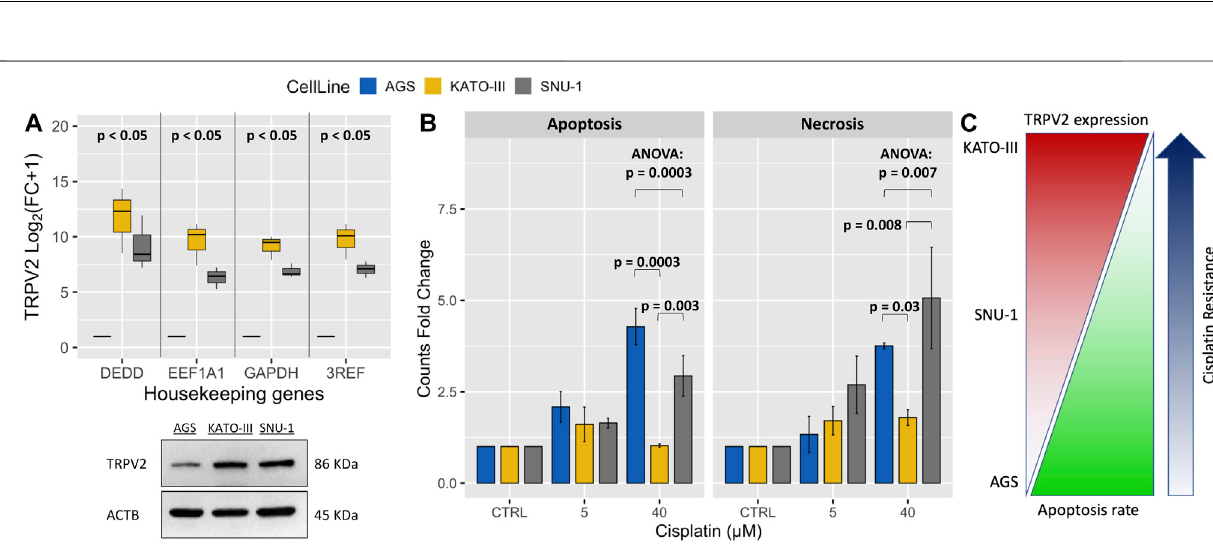
Frontiers in Pharmacology |